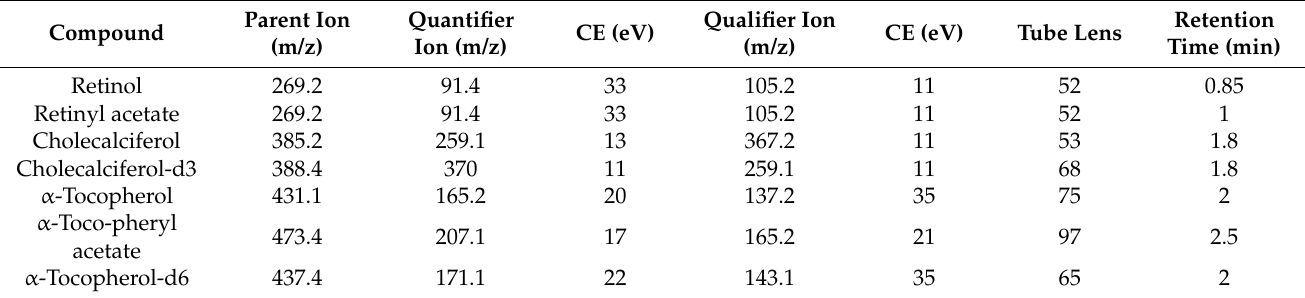
Table 1. Multiple Reaction Monitoring (MRM) transitions of the studied